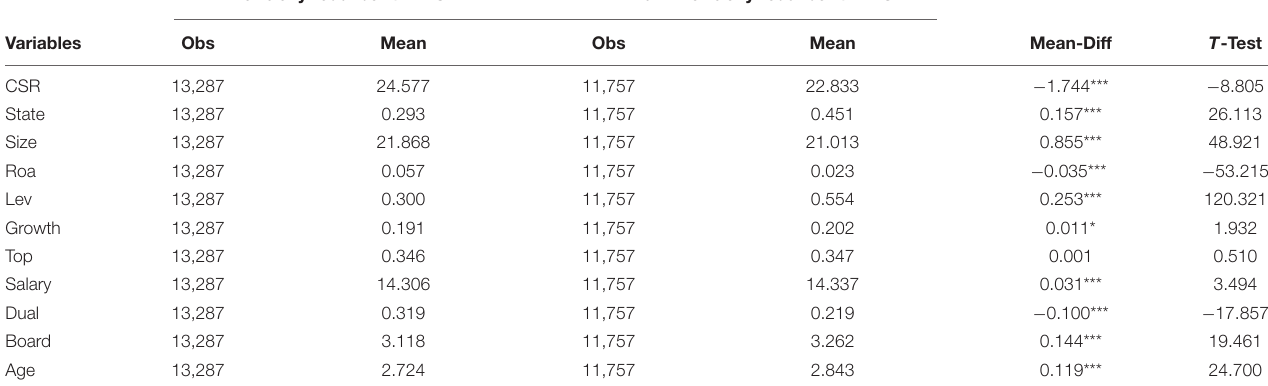
TABLE 2 | Univariate